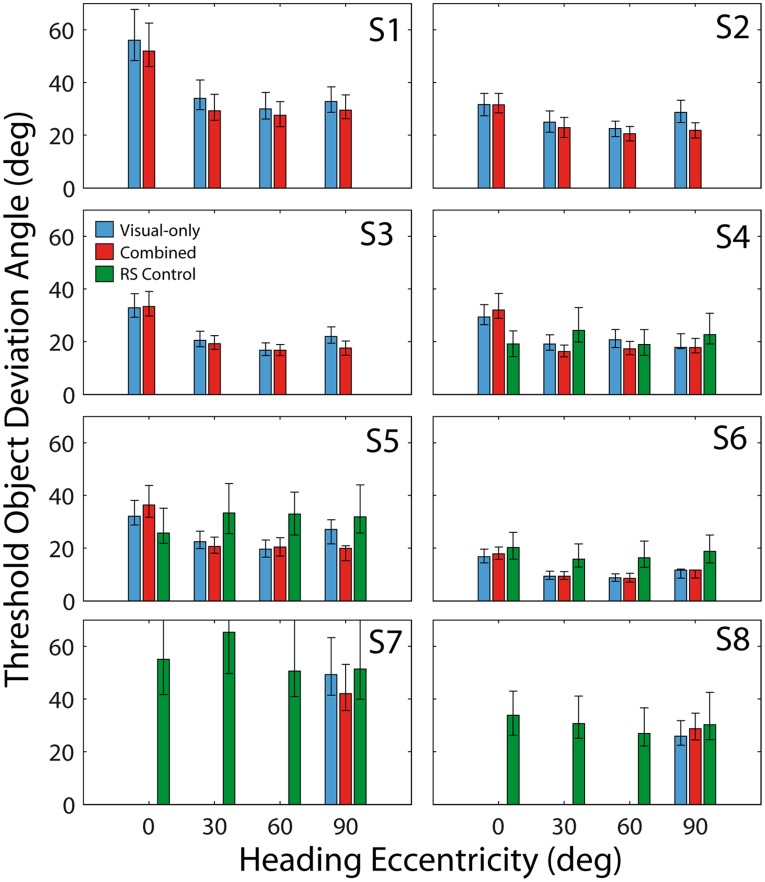
Summary of discrimination thresholds.Each panel shows the data from a different subject. Error bars represent 95% confidence intervals. Subjects S1-S6 participated in the main experiment, so visual-only (blue bars) and combined (red bars) thresholds were measured at all heading eccentricities. Subjects S4-S8 participated in the retinal speed (RS) control experiment (green bars). Note that subjects S7 and S8 were only tested with the 90° heading in the eye movement control experiment (lateral motion).